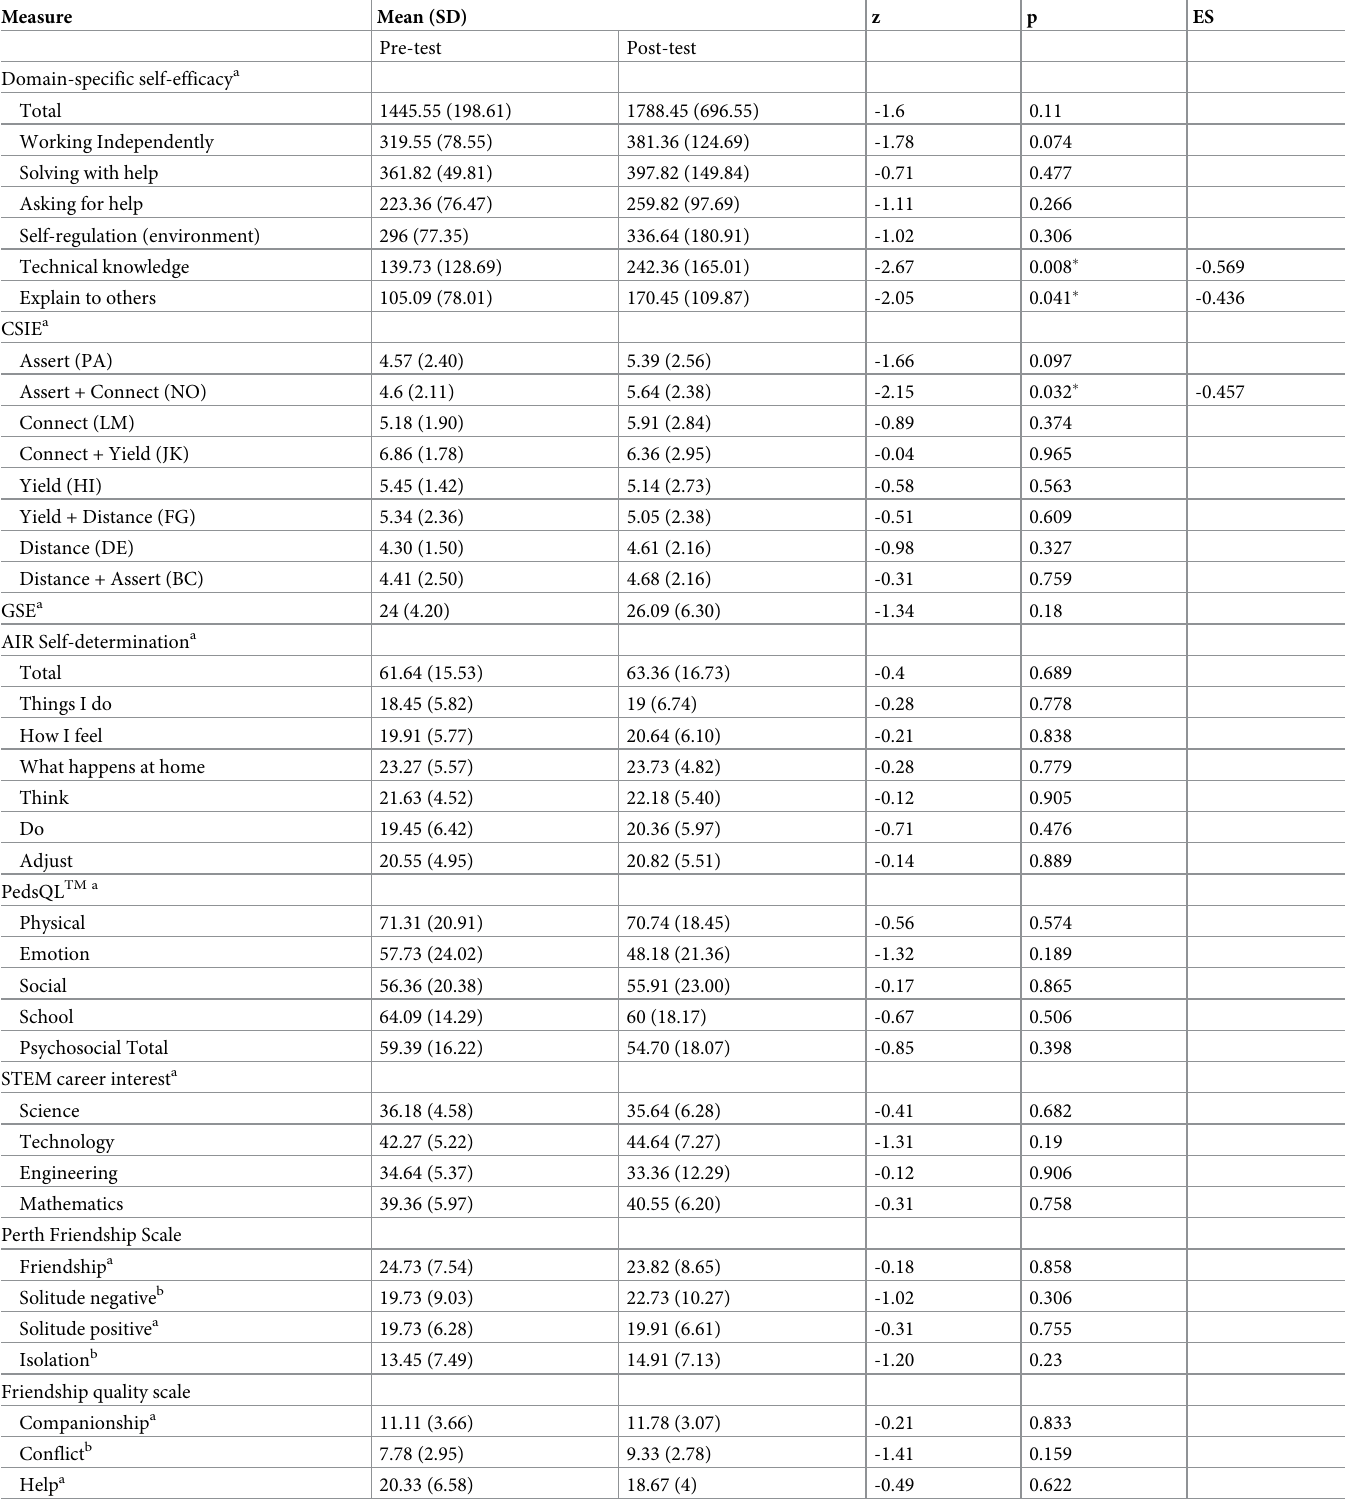
Table 6. Wilcoxon signed-rank test results of adolescent reported